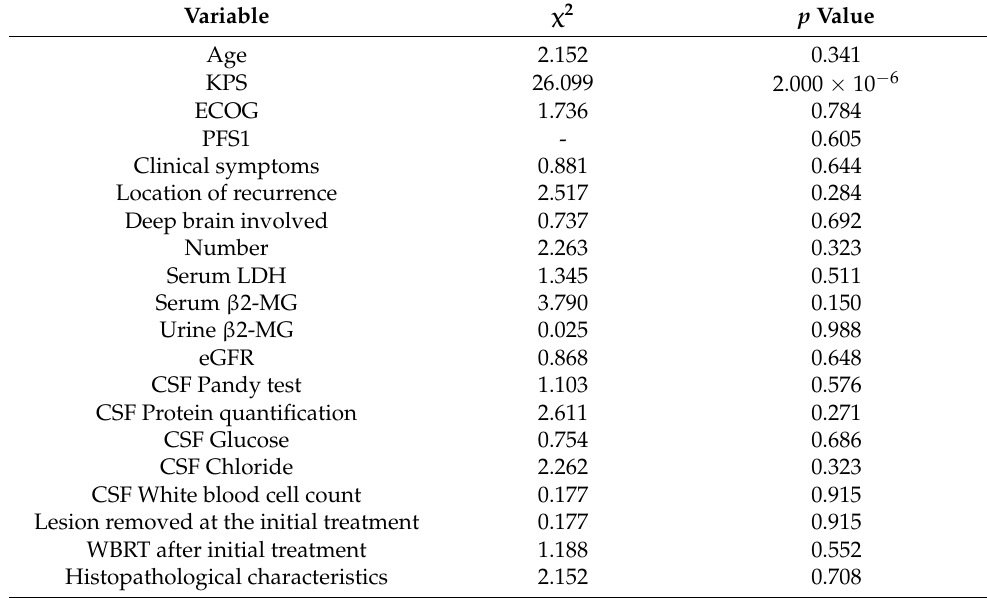
Table 5. Univariate analysis of PFS2 with clinical characteristics.